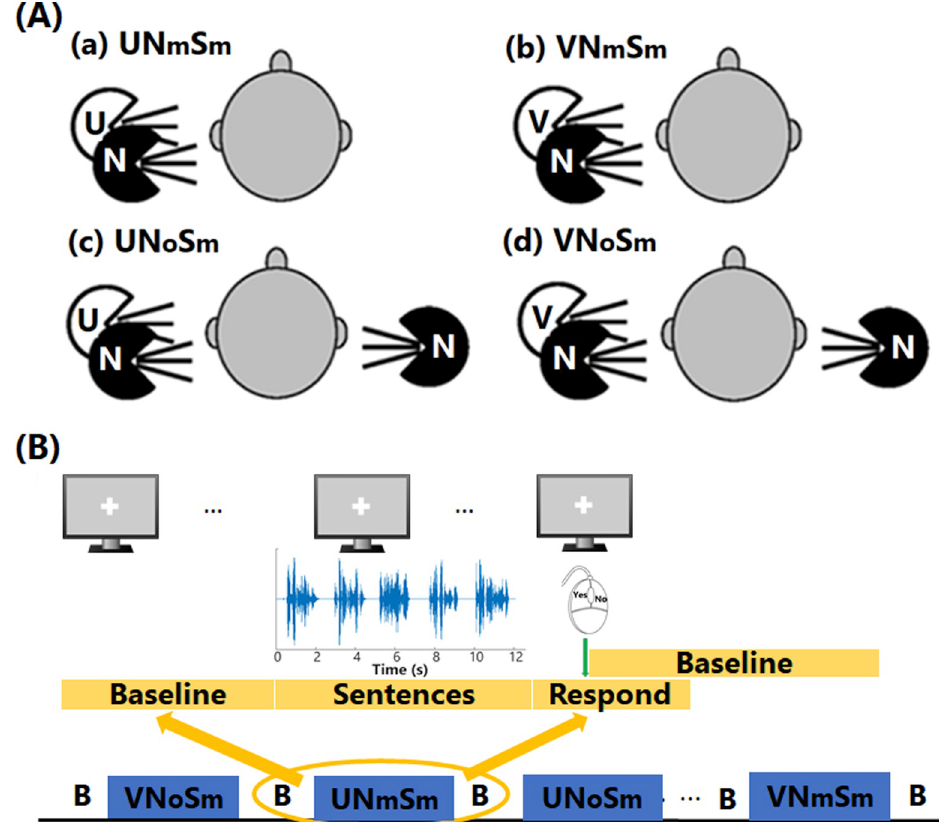
Fig 2. Listening conditions and diagram of fNIRS data collection. In panel (A), the white loudspeakers are for unprocessed (U) and vocoded (V) speech; the black loudspeakers are for noise (N), monaurally (N m S m ) or diotically (N o S m ) presented. Panel (B) shows the pseudorandom block design used for data collection, with stimuli in 4 listening conditions (blue boxes) being presented in random order in each